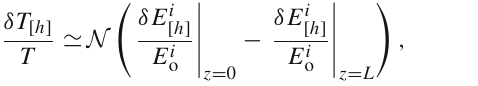
Fig. 1 An illustration of a pulsar timing array (PTA) together with the detector frame and the GW